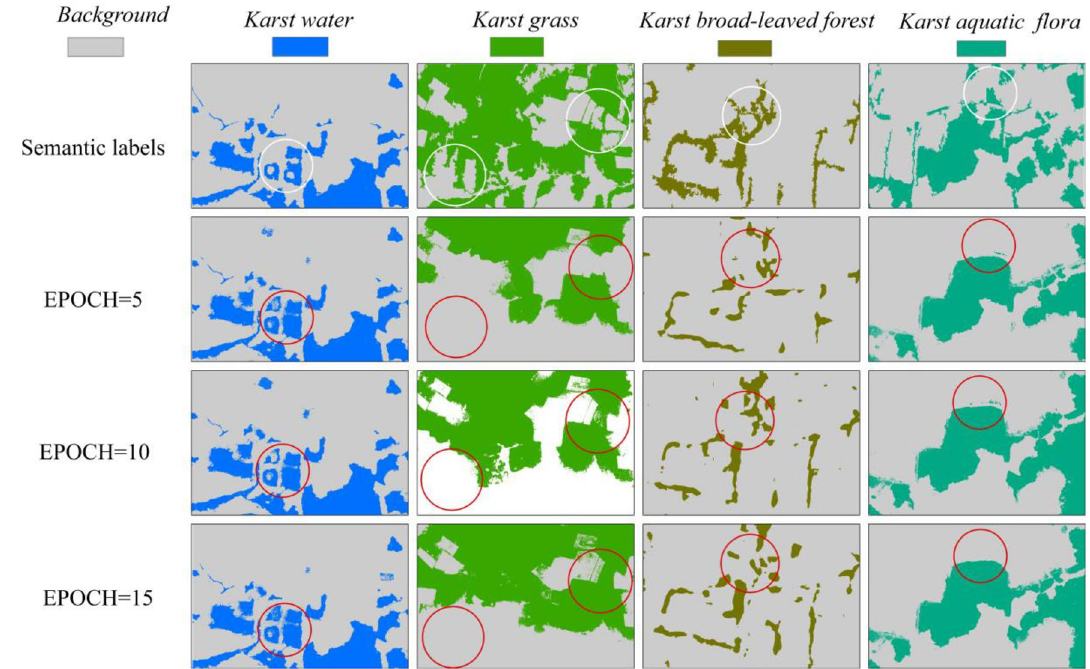
Figure 6. Single-class SegNet-based classifications with different EPOCH values. ArcGIS 10.6 software (http:// www. esri. com/ softw are/ arcgis) was used to process and map the data by first author (T. D.) and corresponding